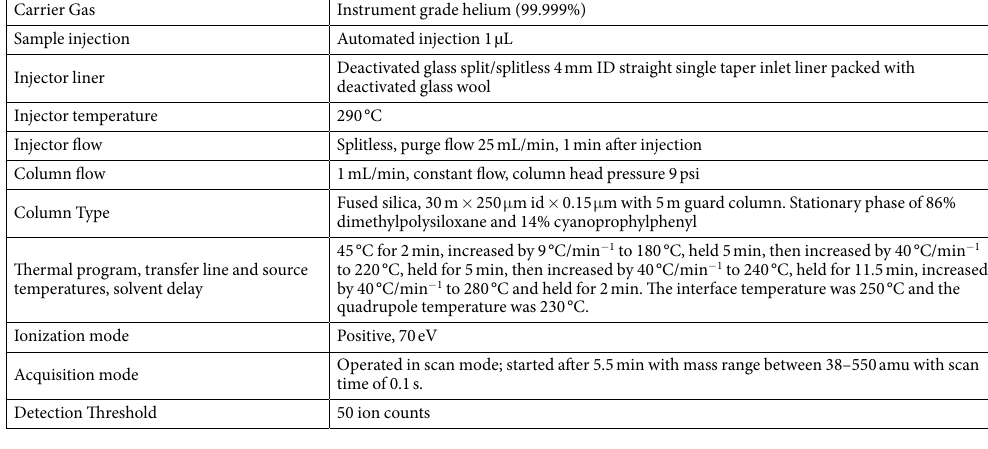
Table 4. GCMS instrument